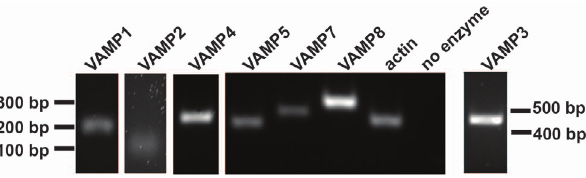
Figure 1. VAMP isoforms in MDCK cells. (A) mRNA isolated from MDCK cells and converted to cDNA was subjected to reverse transcription PCR using primers designed to detect VAMP isoforms. VAMP1 (218 bp expected product), VAMP2 (101 bp), VAMP3 (462 bp), VAMP4 (244 bp), VAMP5 (216 bp), VAMP7 (261 bp), and VAMP8 (298 bp) were detected. Actin (231 bp) was detected as an additional control to ensure amplification of mRNA and reverse transcriptase was excluded from the indicated sample as a negative